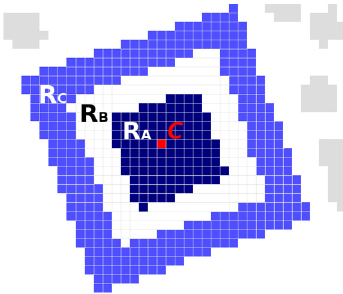
Figure 6. Connected components of the finder pattern candidate.